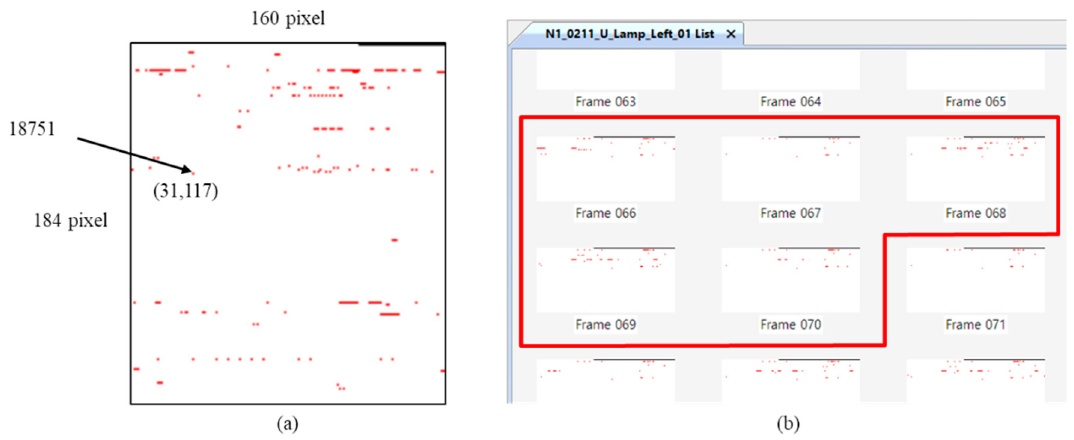
Figure 6. Example of transforming memory-updated information into image files. ( a ) Example of a memory-updated snapshot; ( b ) transforming each frame into image files.